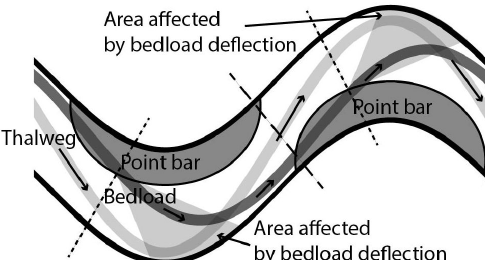
Figure 5. Schematic illustration of the thalweg (light grey) and gravel bedload path (dark grey) through a meandering channel, after the observations of Dietrich and Smith (1984) and Julien and An- thony (2002). Uncovered bedrock is depicted in white and gravel point bars in dark grey. Flow is from left to right. Dotted lines show the relevant cross section for particle deflection. Areas that are pre- sumably affected by bedload particle deflection and should lead to wall erosion are shaded in light grey. The dashed line is placed at the inflection point of the channel centre